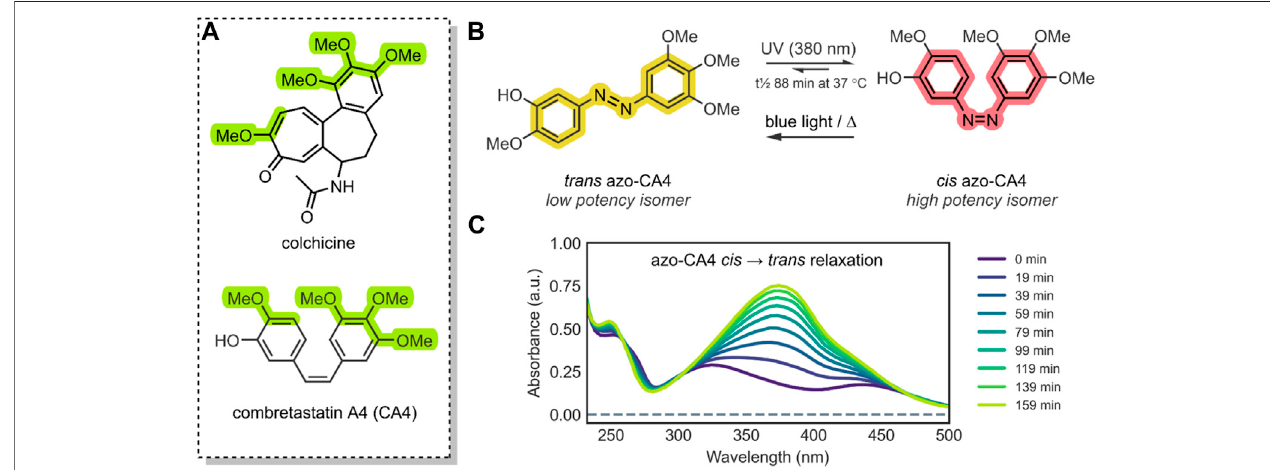
FIGURE 3 | (A) The structure of CA4 (antagonist of the colchicine-receptor of tubulin) and colchicine; the pharmacophore of CA4 has been highlighted green (Borowiak et al., 2015). The azobenzene core has been highlighted; the colours, yellow ( trans azobenzene) and red ( cis azobenzene), are roughly representative of the compounds ’ physicalcolour(Hofmannetal.,2012;Norikaneetal.,2016). (B) Theisomerisationof trans azo-CA4to cis azo-CA4(Sheldonetal.,2016).The cis azo-CA4 mimicsthestructure ofCA4 (Mulatihanet al., 2020). (C) UV-VIS absorption spectraofazo-CA4 in DMSO, dark and 37 ° C,after irradiation (380 nm, 1min, 4.4 mW/ cm 2 );thermalrelaxationof cis azo-CA4( λ max ~325&440 nm)to trans azo-CA4( λ max 379 nm)isevident,withat½of~88 min.ThisUV-VISabsorptionspectrumissimilar to other azobenzene species (Rau and Lueddecke, 1982; Poutanen et al.,